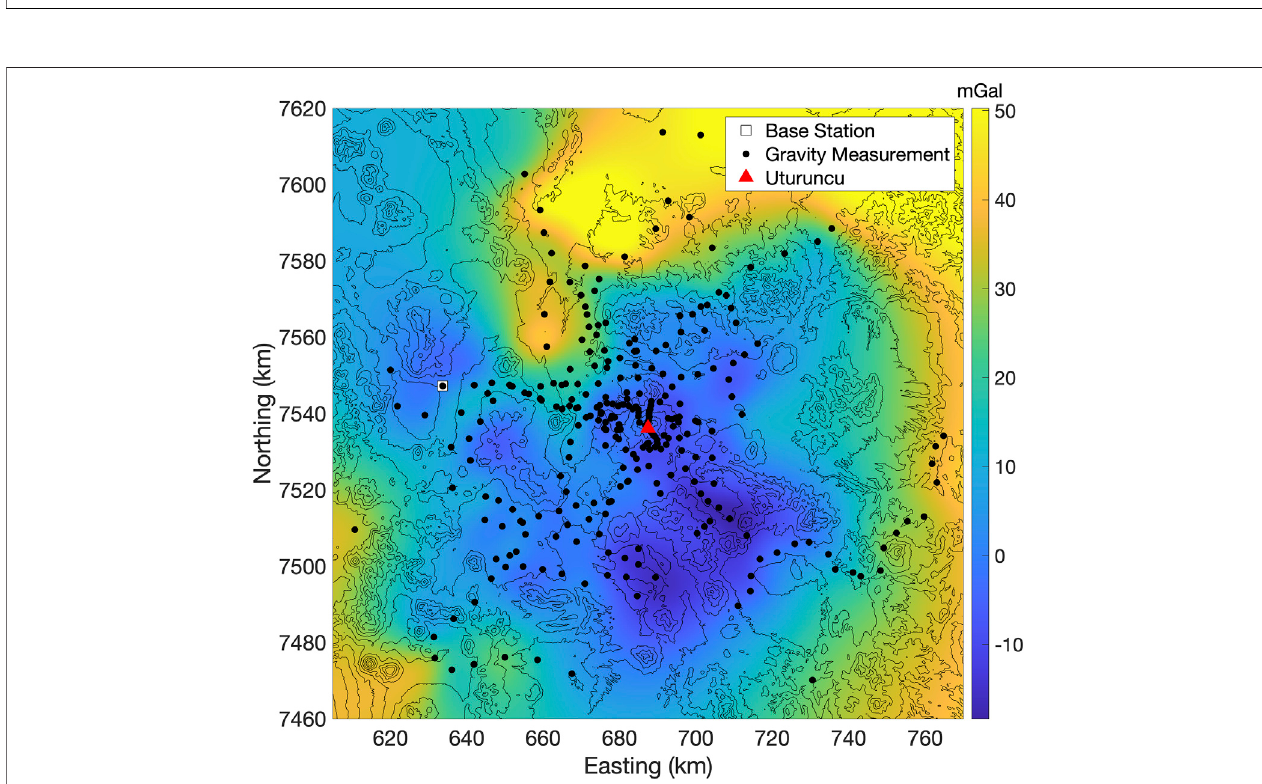
FIGURE3| MapofinterpolatedBouguergravity anomaly( fi llcolor)overlainbytopography(blacklines)fromthe90 mSRTMDEM(Farretal.,2007).Blackdotsare gravity measurement locations, white square is reference station, red triangle is location of Uturuncu.